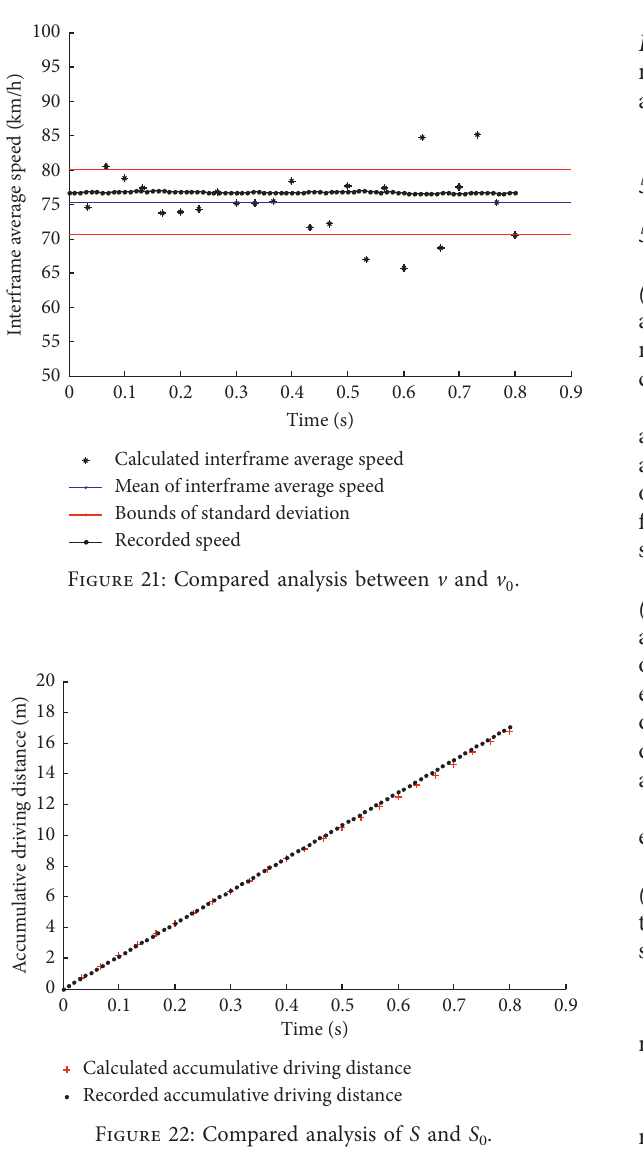
Figure 22: Compared analysis of S and S